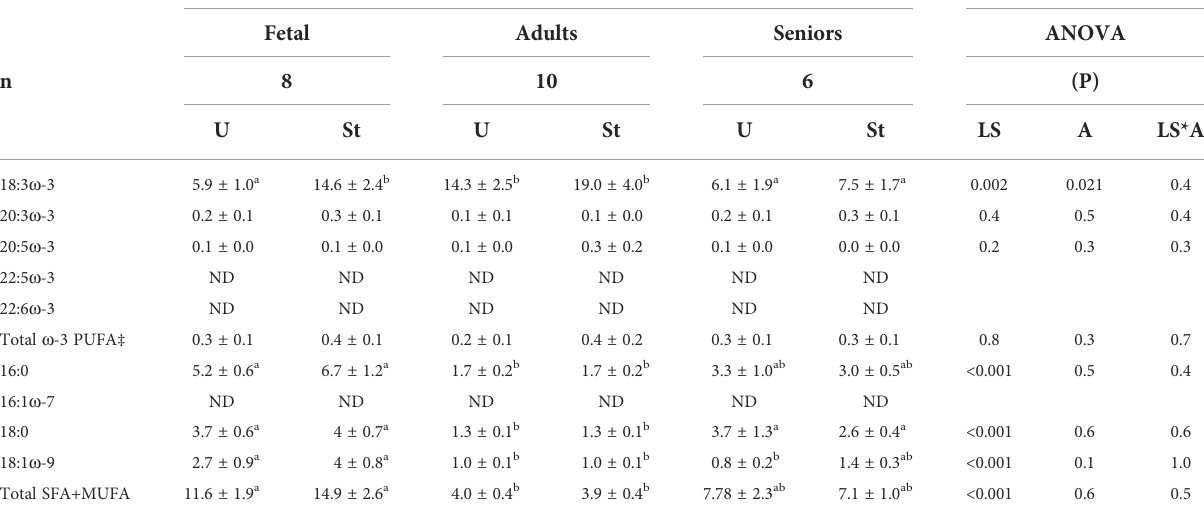
TABLE 2 Amounts of [ 13 C]-labelled fatty acids in unstimulated and mitogen-stimulated T lymphocytes. Amounts of labelled fatty acids (picomoles/10 6 cells)